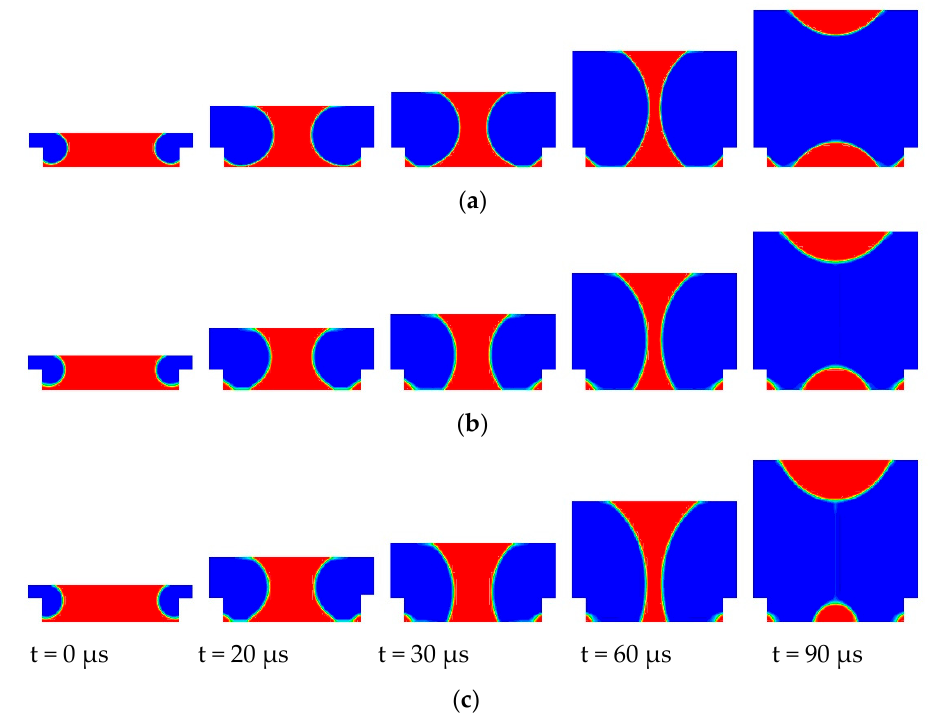
Figure 11. Volume fraction diagram of fluid transfer process. ( a ) α = 30 ◦ , β = 45 ◦ , and h = 11.2 µ m; ( b ) α = 30 ◦ , β = 60 ◦ , and h = 12 µ m; ( c ) α = 30 ◦ , β = 75 ◦ , and h = 13.6 µ Table 3. The critical value of cell depth under different cell contact angles and the remaining cell volume under the combination of the two .